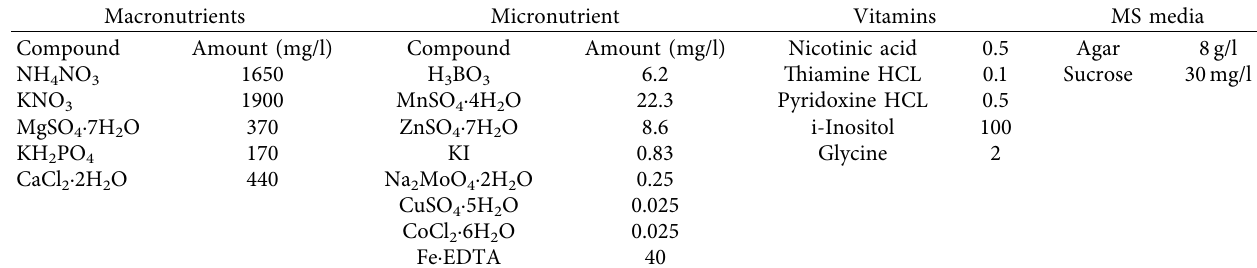
Table 1: Composition of MS